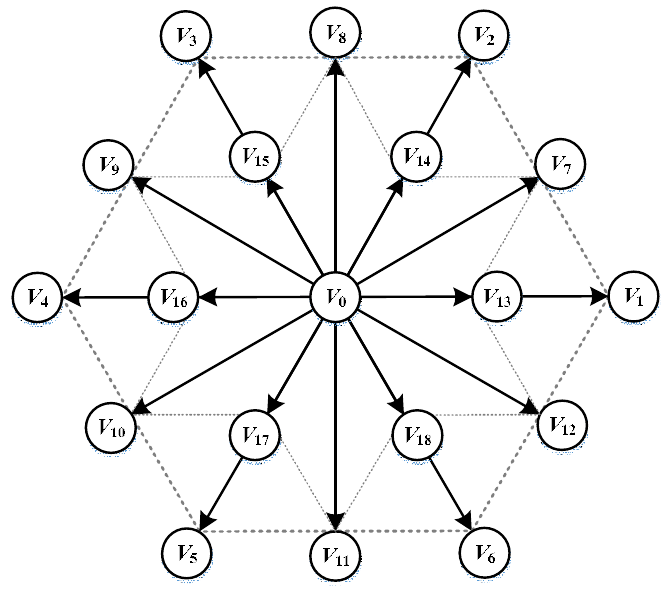
Figure 3. Nineteen synthesized voltage vectors. Table 1. Correspondence between switching modes and the synthesized vectors.